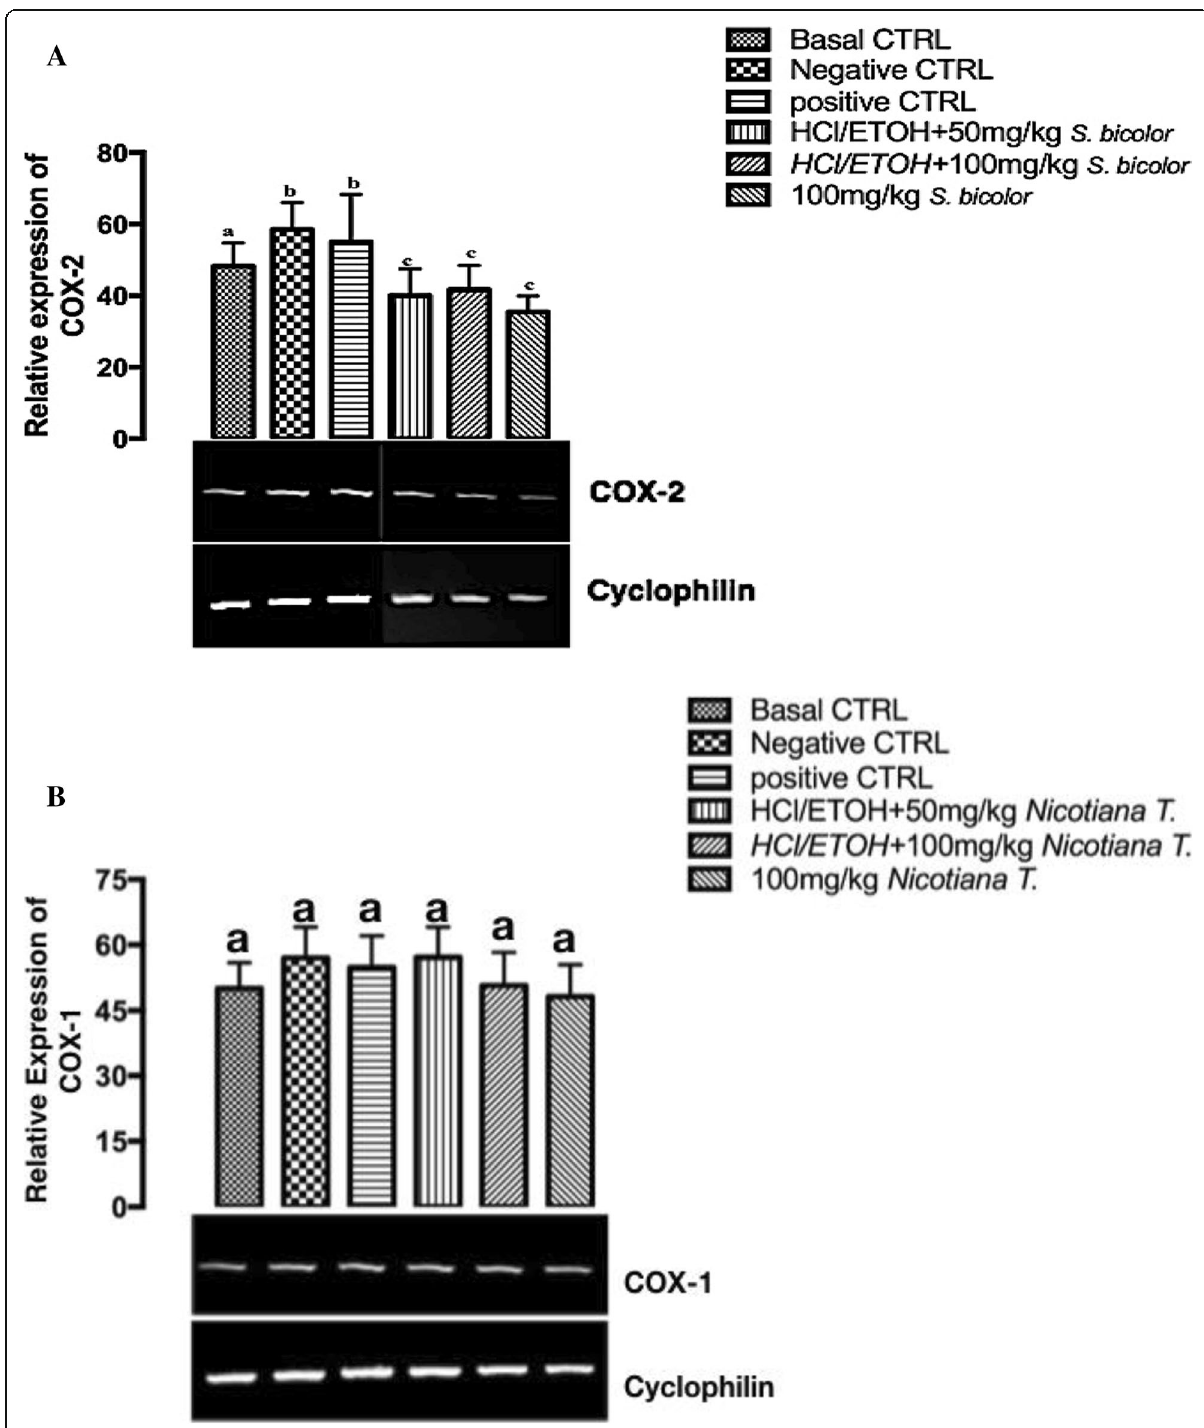
Fig. 6 a Relative expression of COX-2 in the liver of rats in HCl/ethanol-induced inflammation. Values are expressed as mean ± Standard error of mean ( n = 6/group). P < 0.05 is considered to be statistically significant. Bars with different alphabets are statistically significant. b Relative expression of COX-1 in the liver of rats in HCl/ethanol-induced inflammation. Values are expressed as mean ± Standard error of mean ( n = 6/group). P < 0.05 is considered to be statistically significant. Bars with different alphabets are statistically